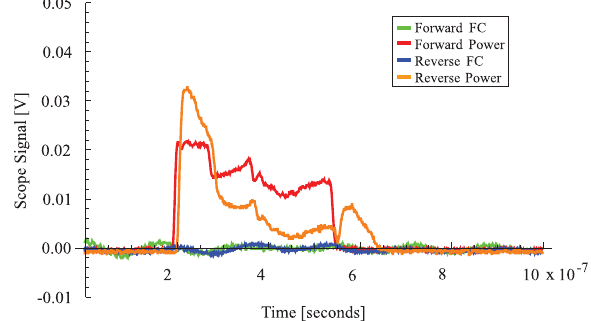
FIG. 14. Breakdown structure scope traces (uncalibrated) for nonbreakdown event. Forward and reverse power in structure, forward and reverse Faraday cup signals. After filling, the forward power into the structure (from the peak power meter) was 5.0 MW for 170 ns for this shot.